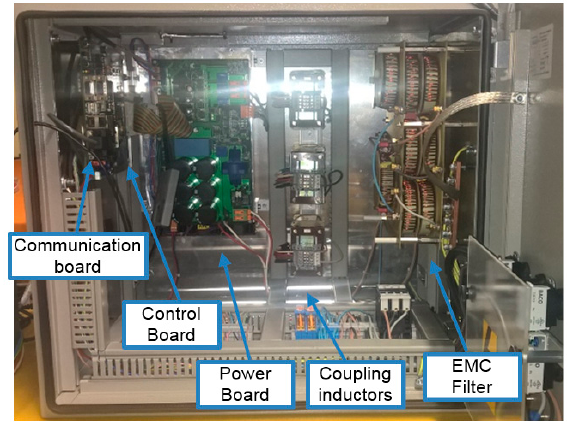
Figure 2. Electrical cabinet.